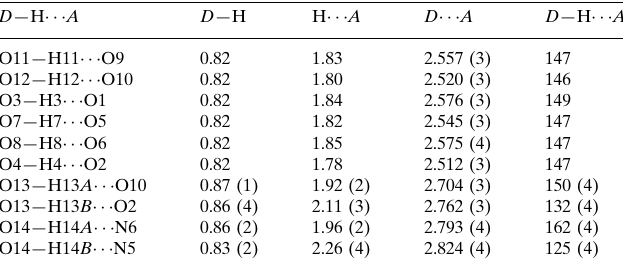
Hydrogen-bond geometry (A ˚ , (cid:3) ). D —H (cid:2)(cid:2)(cid:2)